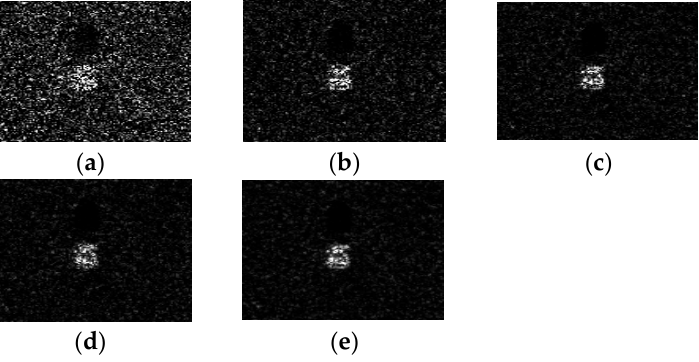
Figure 17. SAR images with different ENLs. ( a ) ENL = 0.5; ( b ) ENL = 0.6; ( c ) ENL = 1; ( d ) ENL = 1.5; ( e ) ENL = 2.